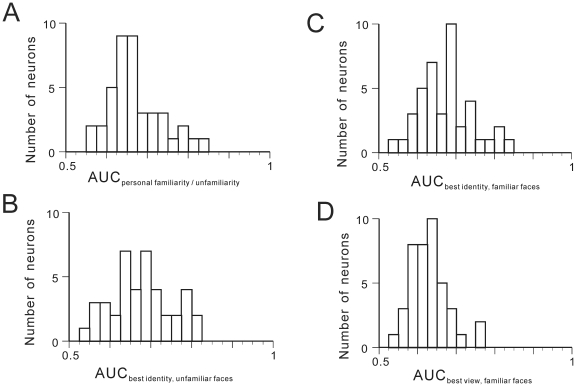
Individual selectivity to personal familiarity, facial identity and
facial view: ROC analysis (N = 41).
A. Frequency distribution of AUCpersonal
familiarity/unfamiliarity. B. Frequency
distribution of AUCbest identity, unfamiliar faces.
C. Frequency distribution of AUCbest identity,
familiar faces. D. Frequency distribution of
AUCbest view, familiar faces.